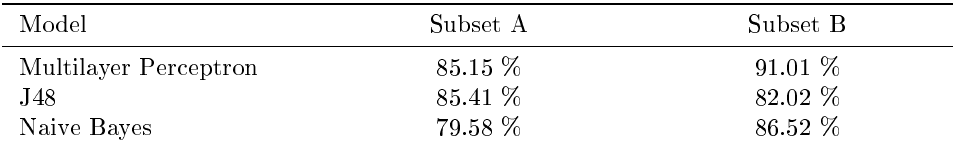
Table 2: Performance of Models